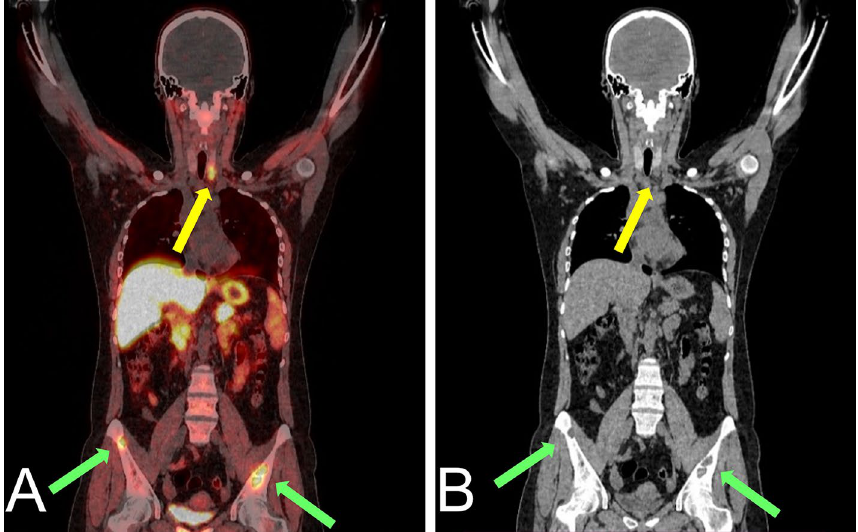
Fig. 5 Coronal [ 18 F]fluorocholine PET/CT images of hyperfunctioning parathyroid tissue (yellow arrows) on lower left parathyroid lodge and avid lesions involving iliac bone bilaterally (green arrows) (SUVmax 4.5 on the left and 7.9 on the right) ( A ) and CT coregistration ( B